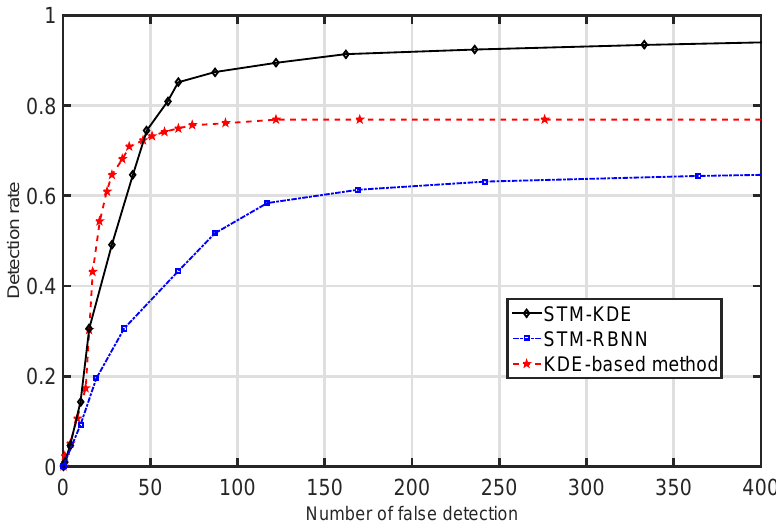
Figure 11. ROC curve in the range of 15 m.